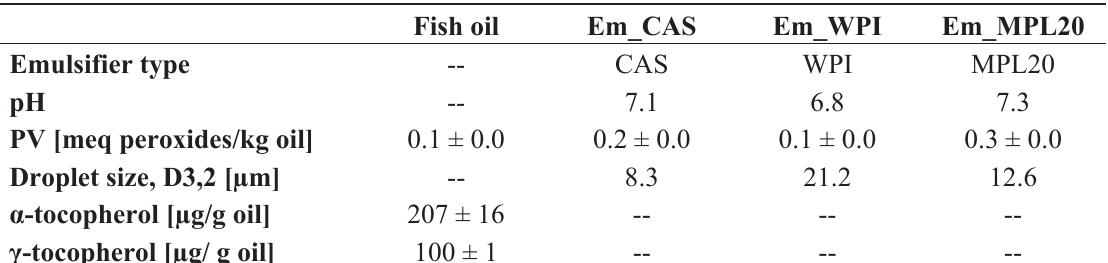
Table 2. Data on fish oil and delivery emulsions used for production of the cream cheese